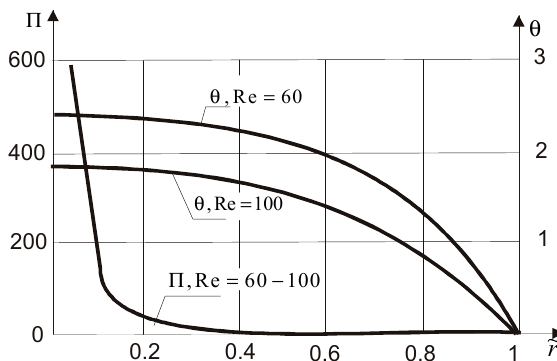
Figure 2. Distribution of dimensionless pressure drop, Π , and dimensionless temperature.